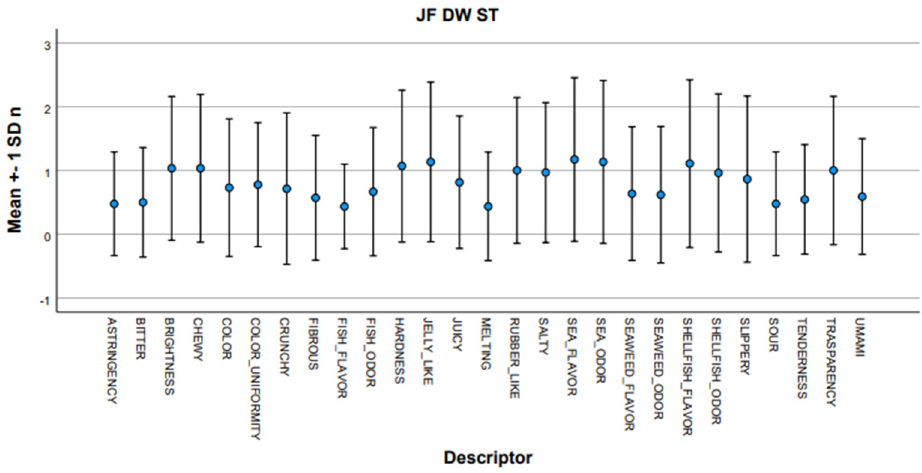
Figure 7. Error bar of the intensity mean score for descriptors selected for sample JF-DW-ST. Bars represent standard deviation.